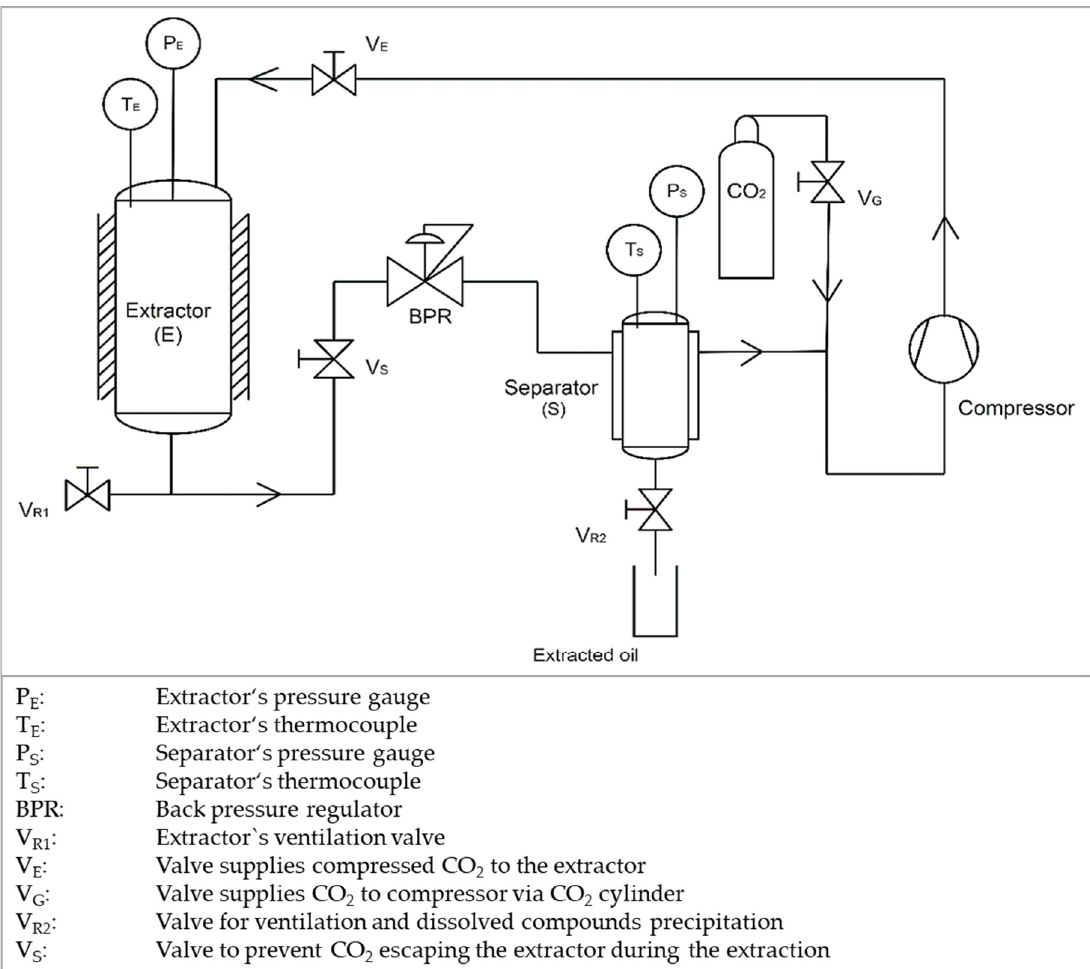
Figure 1. A schematic presentation of the supercritical extraction (SCE) system utilized in this experiment.